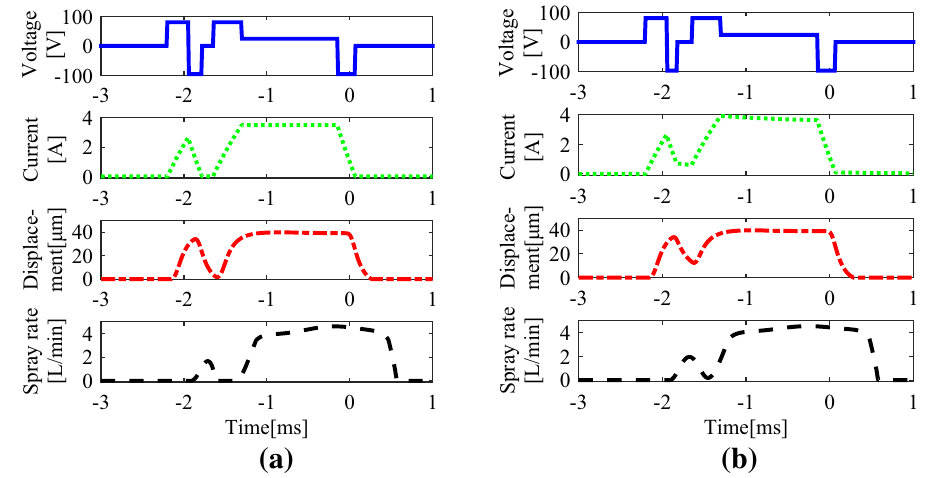
Figure 6. Simulation profiles of the voltage, coil current, ball valve lift and spray rate of the double injection and boot shape injection: ( a ) double injection; ( b ) boot shape injection.